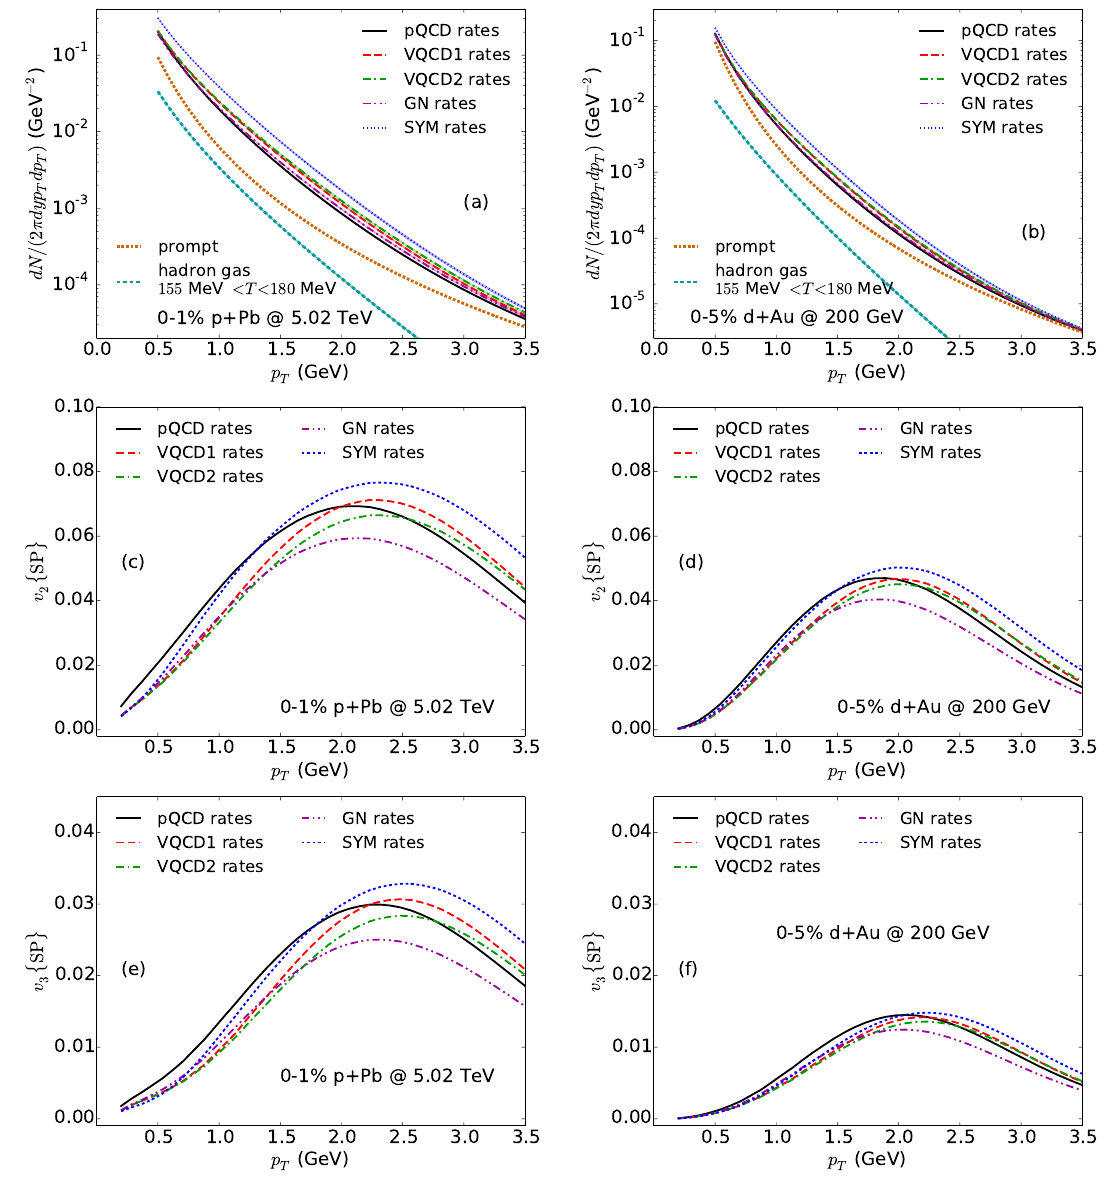
Figure 7 . (Color online) Direct photon spectra from 0{1% p+Pb collisions at 5.02 TeV (a) and 0{5% d+Au collisions at 200 GeV (b) using di(cid:11)erent sets of emission rate in the QGP phase. Direct photon anisotropic (cid:13)ow coe(cid:14)cients, v 2 ; 3 ( p T ), in 0{1% p+Pb collisions at 5.02 TeV (c,e) and 0{5% d+Au collisions at 200 GeV (d,f) using di(cid:11)erent sets of emission rate in the QGP